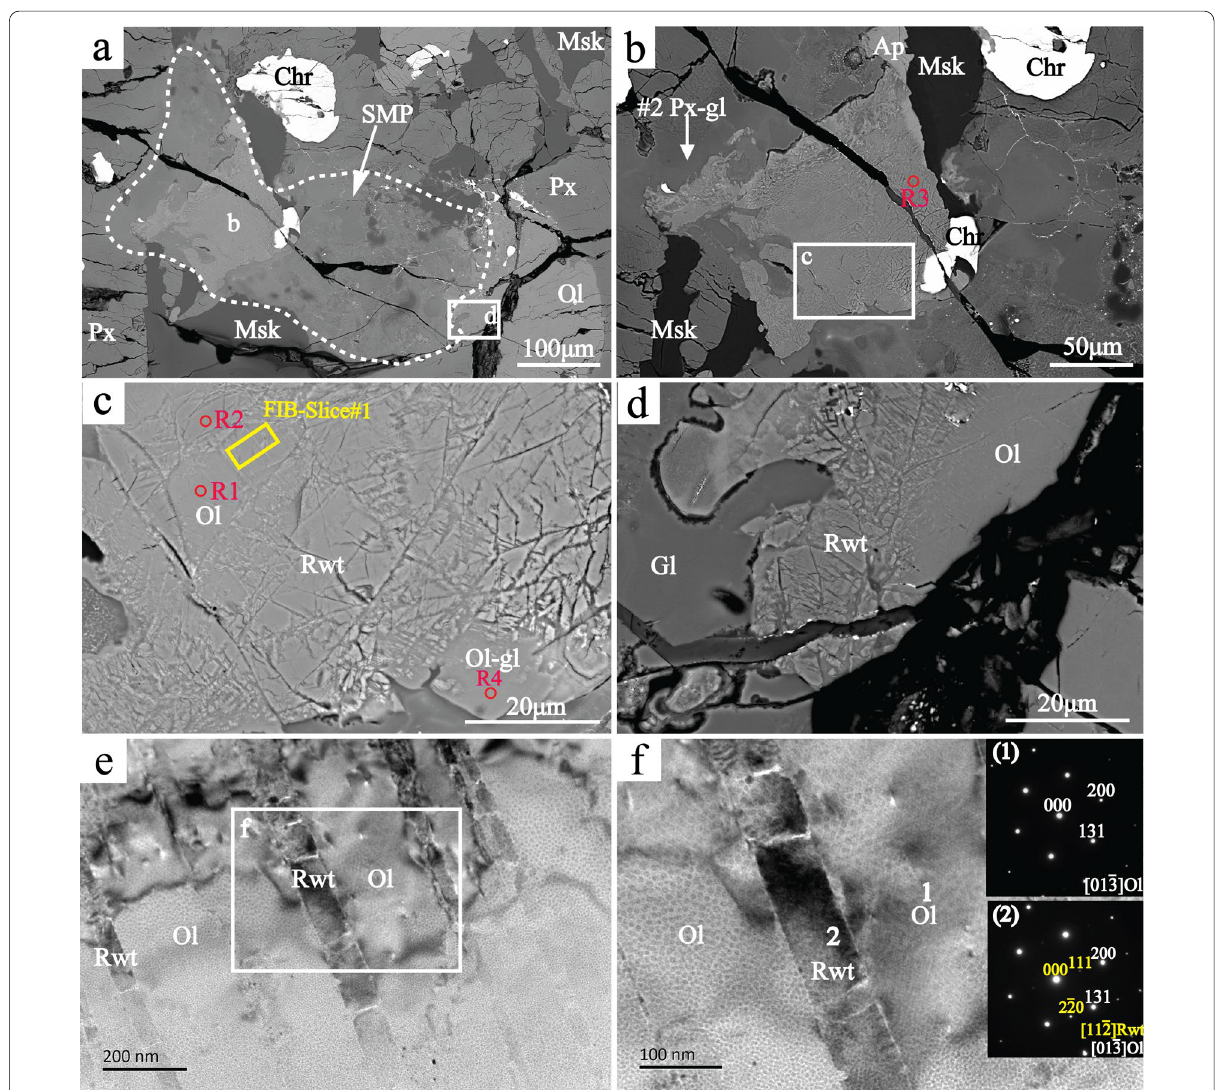
Fig. 2 BSE images of ringwoodite lamellae. a shock-induced melt pocket (SMP) outlined by the dotted line. The grain labeled “b” and the white box labeled “d” are shown in b and d , respectively. b High magnification image of grain “b”, showing significant heterogeneity. Raman analyses were conducted on the adjacent pyroxene (#2 px-gl) and on the lamellae (R3). c Enlarged image of white box “c” in b reveals ringwoodite (Rwt) lamellae intergrown with the host olivine (Ol). R1, R2, and R4 are the analyses positions of Raman spectra. The yellow box indicates the position of FIB-slice #1. d Enlarged image of white box “d” in a shows that the olivine in contact with the glass phase (Gl) has been transformed into ringwoodite lamellae. e Bright-field (BF) TEM image from the FIB-slice #1. The lamellae parallel to each other. f Enlarged BF-TEM image of the white box “f” in e . The SAED pattern of region 1 shows olivine viewed along the crystal zone axis [01 3 ]. The SAED pattern of region 2 shows that crystallographic relationship {111} Rwt //(100) Ol exist. SMP shock-induced melt pocket, Ap apatite; others are the same as